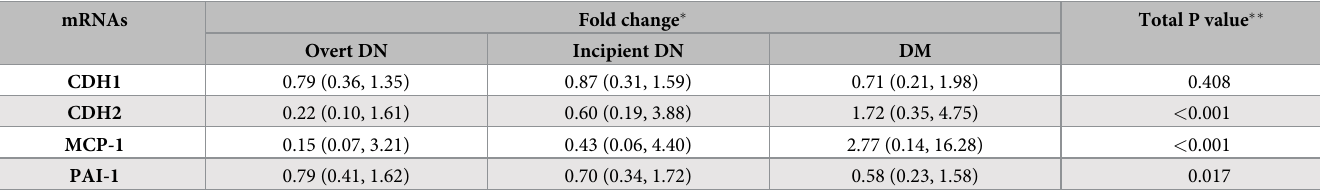
Table 3. Relative mRNA expression fold change in overt DN group, incipient DN group, and DM group compared to control. mRNAs Fold change � Total P value �� Overt DN Incipient DN DM CDH1 0.79 (0.36, 1.35) 0.87 (0.31, 1.59) 0.71 (0.21, 1.98) 0.408 CDH2 0.22 (0.10, 1.61) 0.60 (0.19, 3.88) 1.72 (0.35, 4.75) < 0.001 MCP-1 0.15 (0.07, 3.21) 0.43 (0.06, 4.40) 2.77 (0.14, 16.28) < 0.001 PAI-1 0.79 (0.41, 1.62) 0.70 (0.34, 1.72) 0.58 (0.23, 1.58) 0.017 Data are expressed as median (IQR).